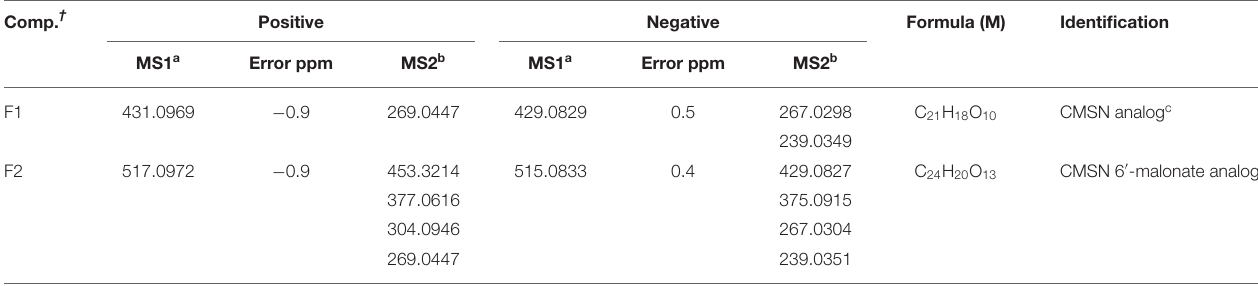
TABLE 1 | Mass identification of the purified coumestrin (CMSN) derivatives. Comp. †